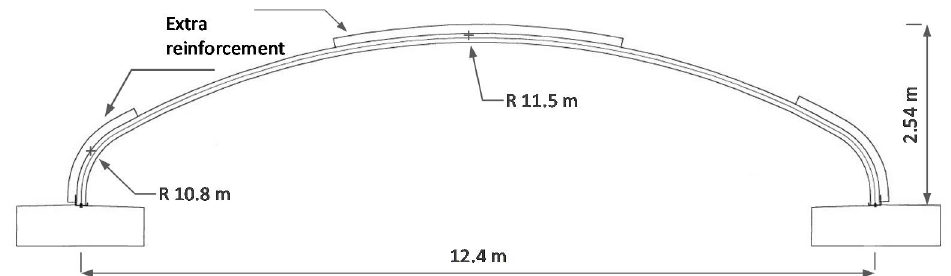
Figure 6. Dimensions of the steel culvert chosen in the study. Table 1. General information about the selected case study bridge